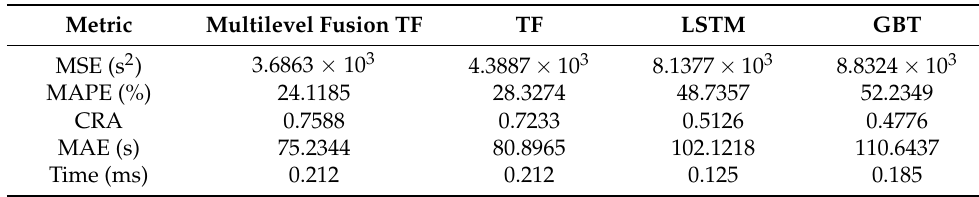
Table 6. One-step RUL prediction performance.